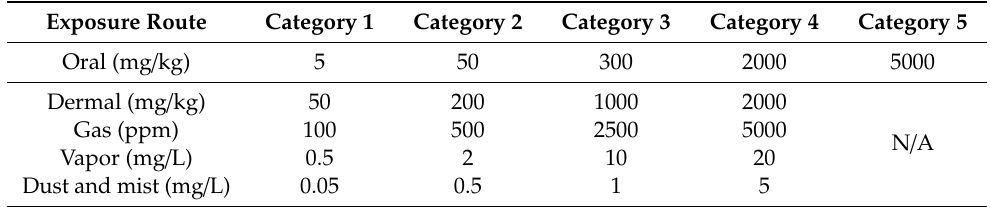
Table 4. Acute toxicity hazard categories and approximate LD50 / LC50 values defining the respective